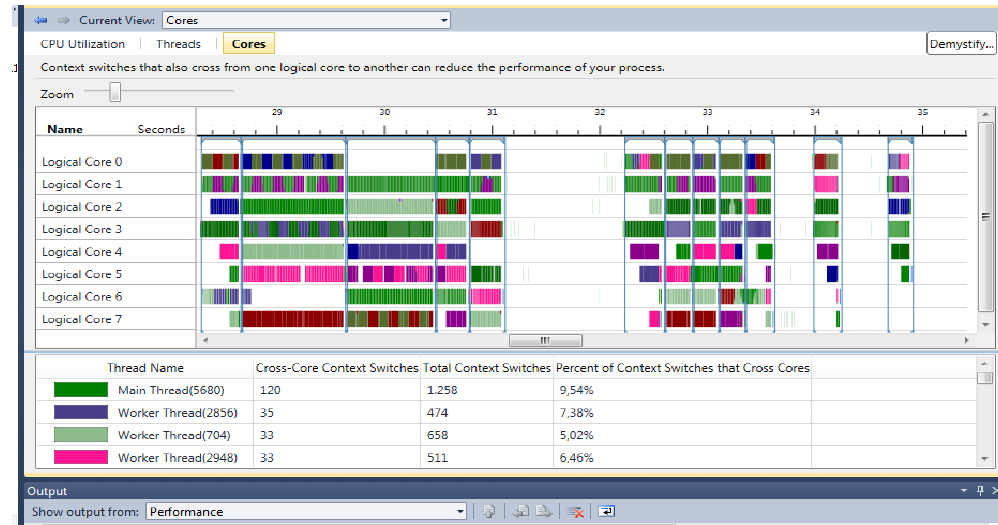
Figure 11. Cores-level analysis.